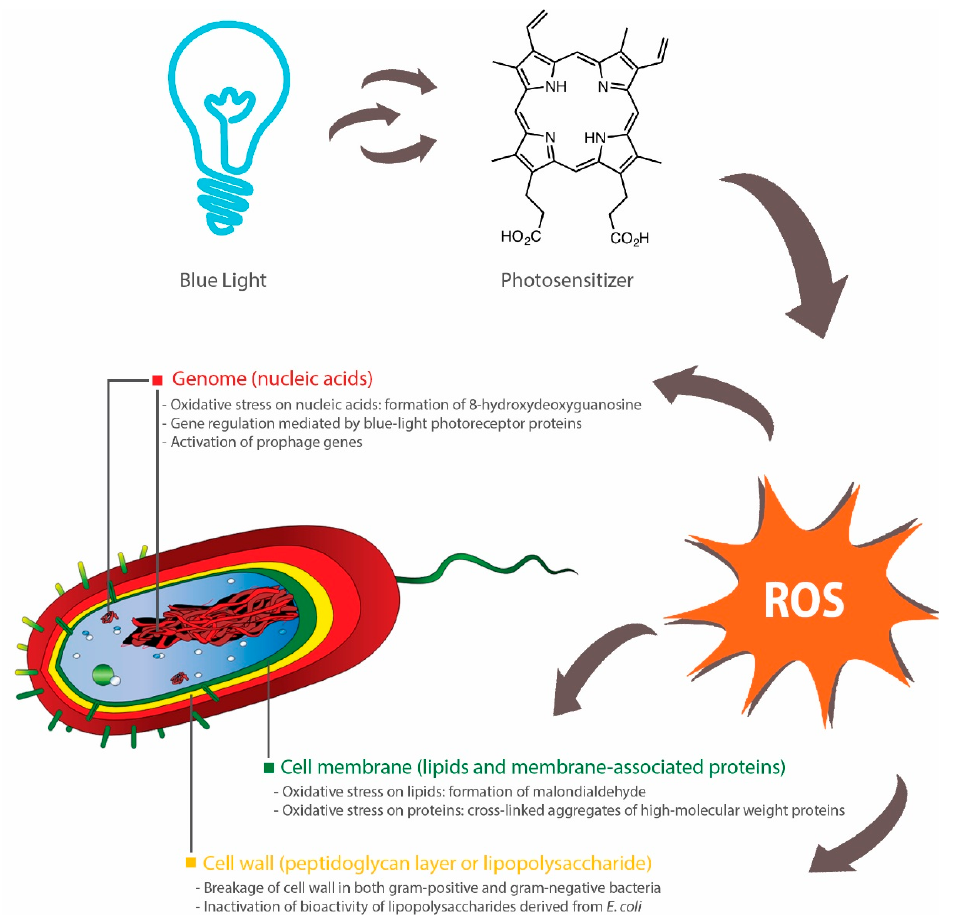
Figure 1. Bactericidal activities of blue light rely on activation of endogenous photosensitizers, such